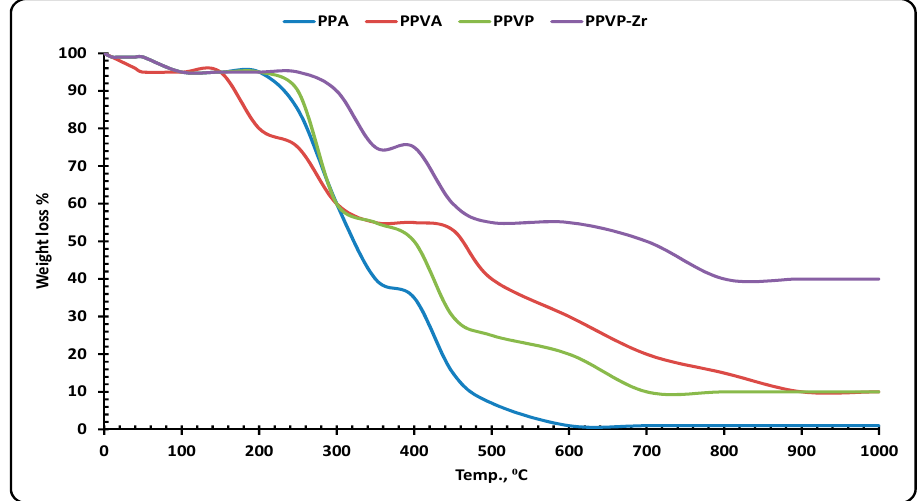
Figure 3. Thermogram of PVA, PPVA, PPVP and PPVP-Zr in N 2 atmosphere.